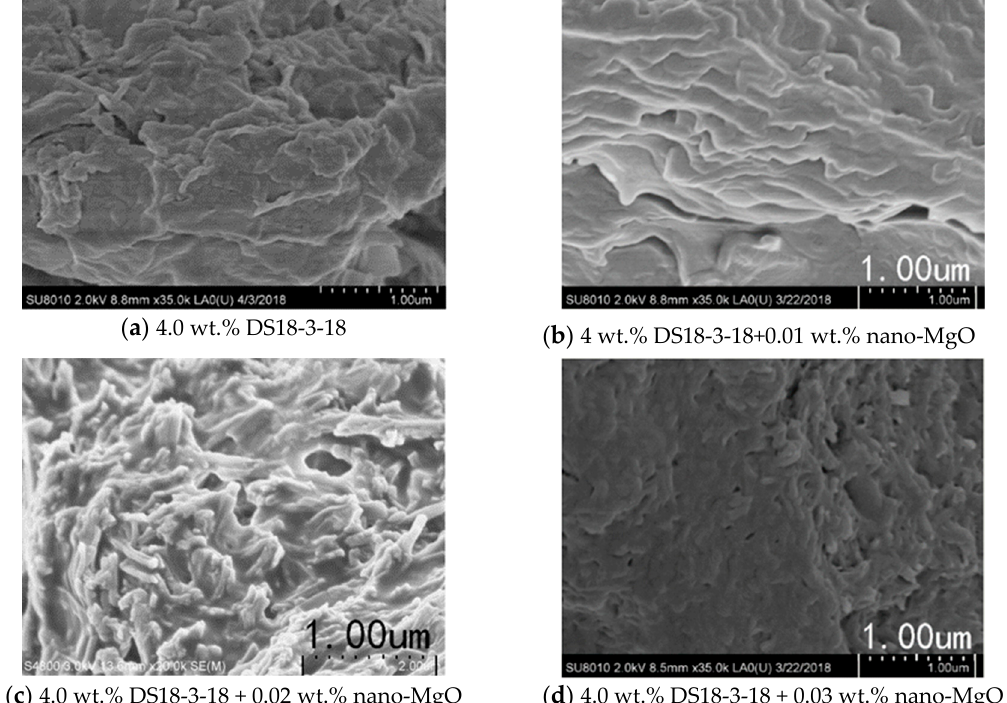
Figure 10. Effect of different concentration of nano-MgO on the micelle structure of DS18-3-18 solution.